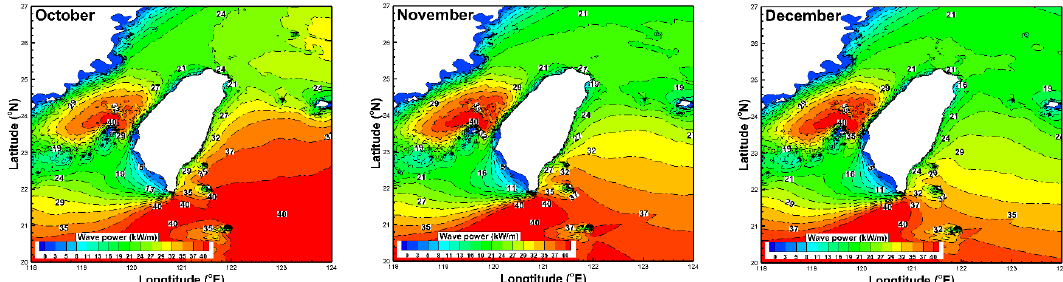
Figure 10. Spatial distributions of the monthly average wave power in the offshore waters of Taiwan from 1991 to 2010.